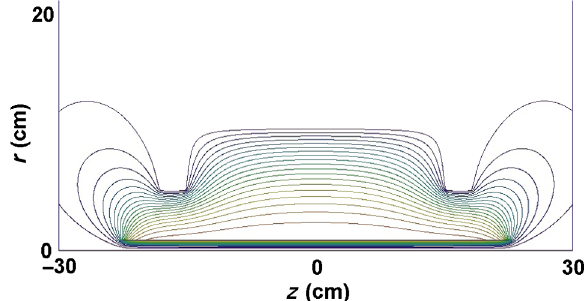
FIG. 4. Magnetic field of calibration coil in the DML apparatus as calibrated.